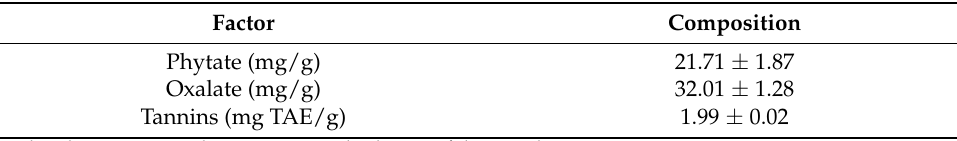
Table 5. Anti-nutritional factors of Balanites roxburghii seed